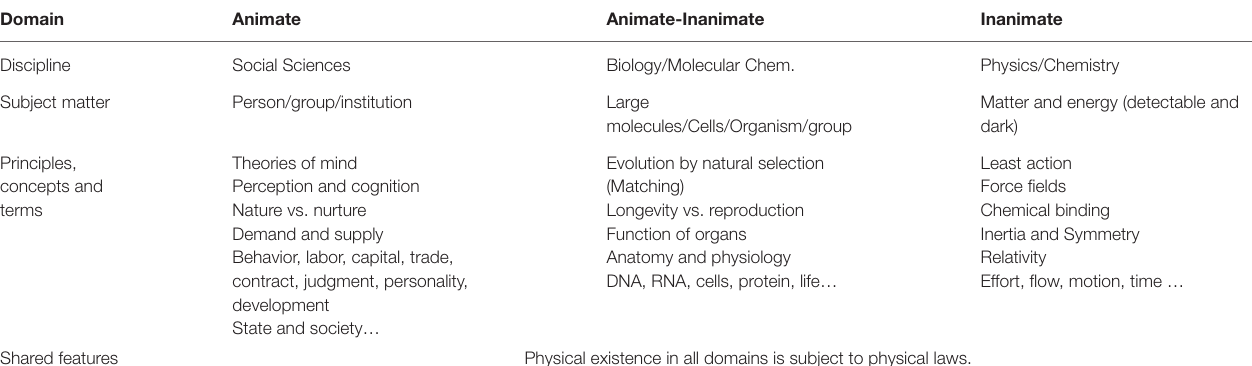
TABLE 2 | Subject matter and principles in three domains of scientific inquiry (Source: Mousavi and Sunder, 2021). Domain